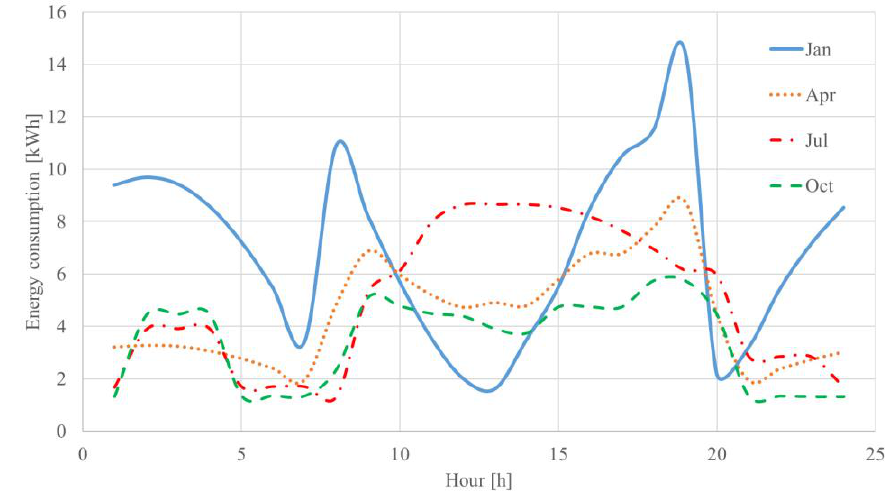
Figure 2. Daily electrical energy consumption for greenhouse with heat pump.